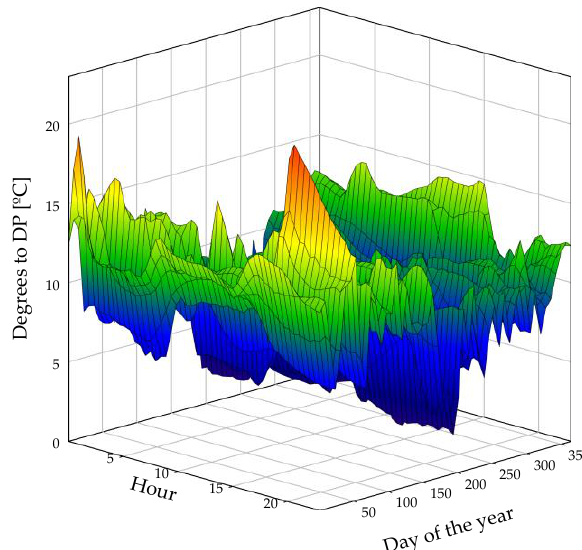
Figure 13. Evolution of the difference of temperature along the year.